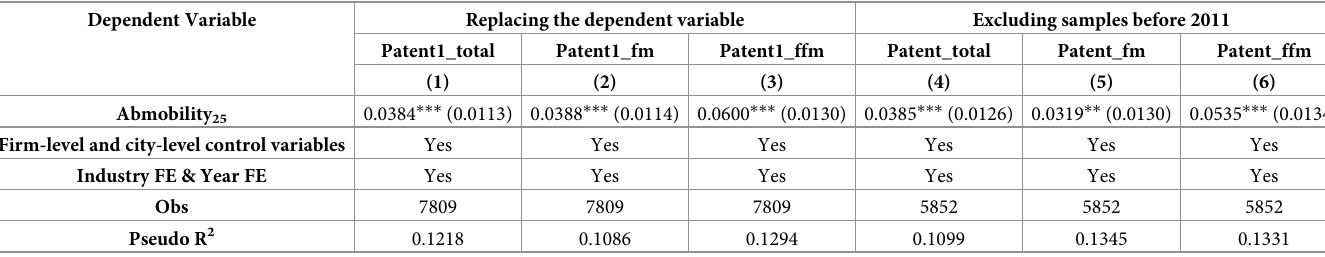
Table 8. Ther robustness